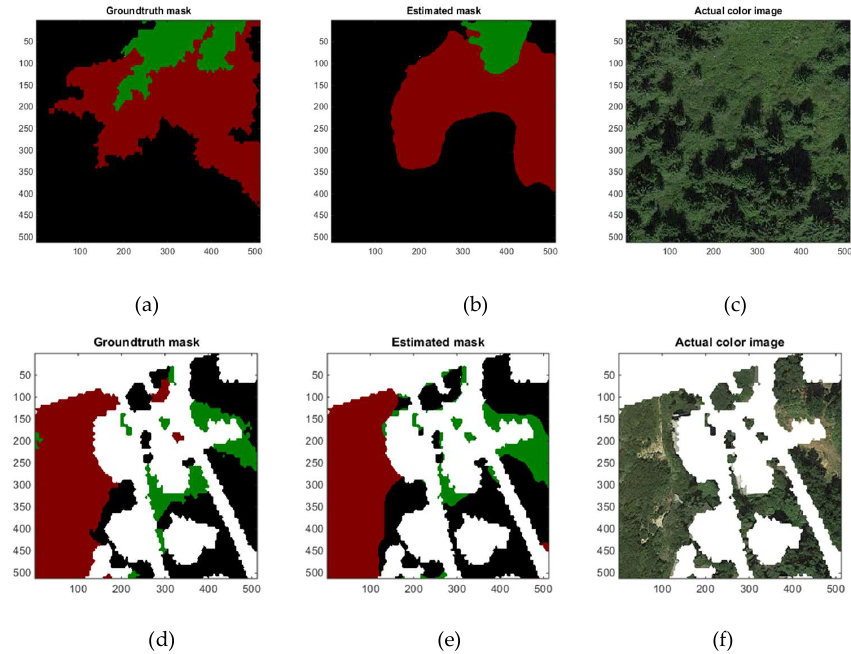
Figure 5. Demonstrations of vegetation class annotations from two samples in Oregon test set (black color corresponds to forest, red color corresponds to grassland, green color corresponds to shrub land, and white color corresponds to ignore class in land cover map annotations). (a) Groundtruth land cover map for test image no: 13; (b) estimated land cover map for test image no: 13; (c) color image for test image no: 13; (d) groundtruth land cover map for test image no: 79; (e) estimated land cover map for test image no: 79; (f) color image for test image no: 79.